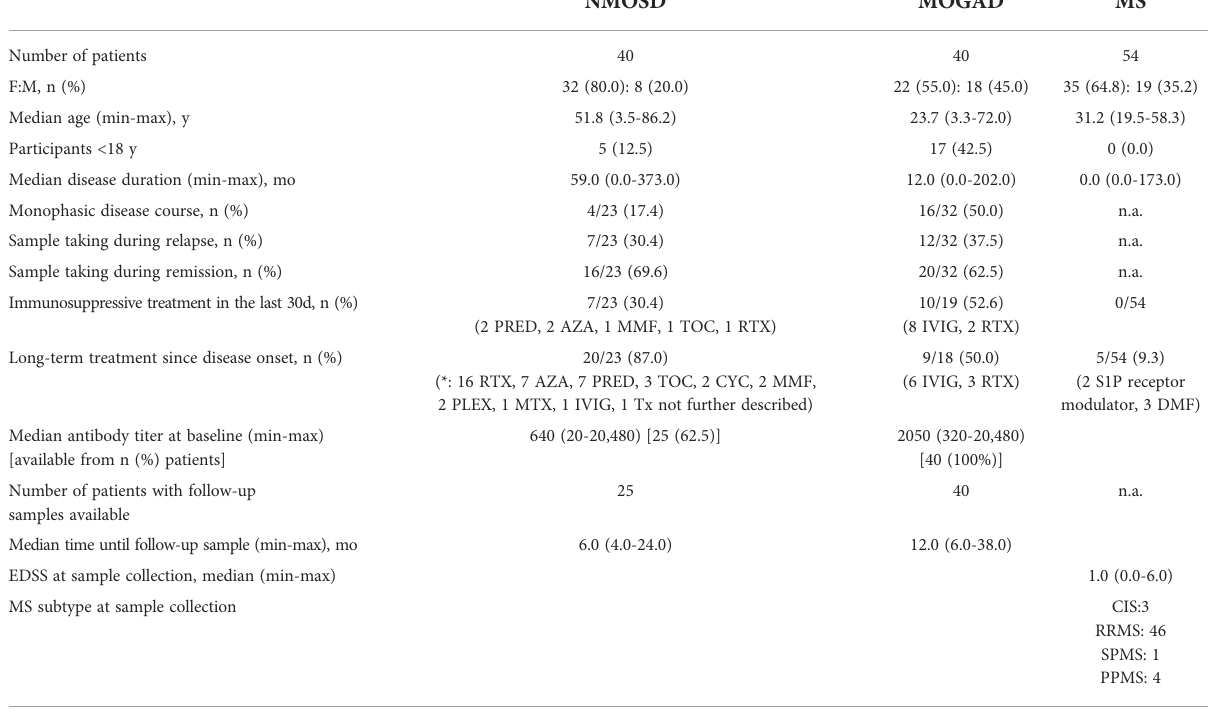
TABLE 1 Demographic baseline characteristics of study